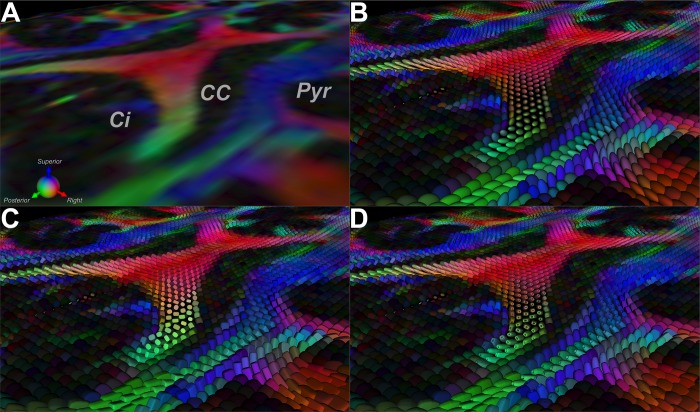
Diffusion tensor representations of a normal brain near the splenium.FA map near the splenium in a normal brain color-coded by the orientation of the primary eigenvector (A). Rendering of this region using ellipsoidal (B), superquadric (C), and supertoroidal (D) glyphs using the same orientation encoding. Supertoroidal glyphs enhance the visualization of local structure and orientation due to the increase in the shape genus.